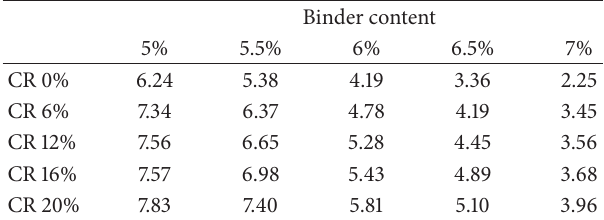
Table 8: VIM results (%) for different CRM